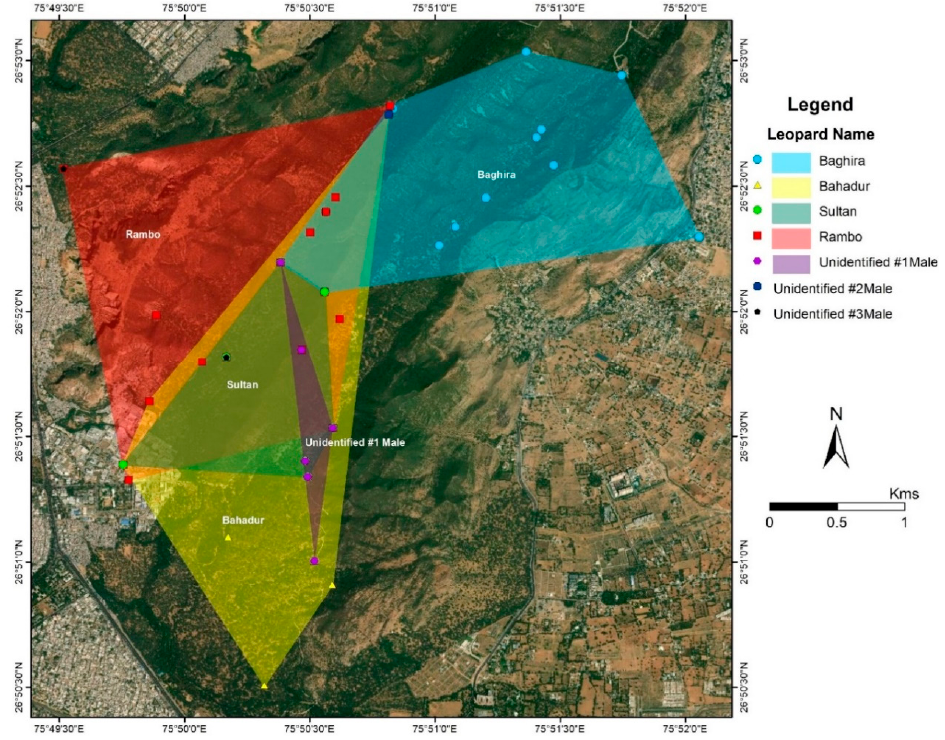
Figure 5. Home-ranges (MCPs) of male leopards of Jhalana Reserve Forest, India.